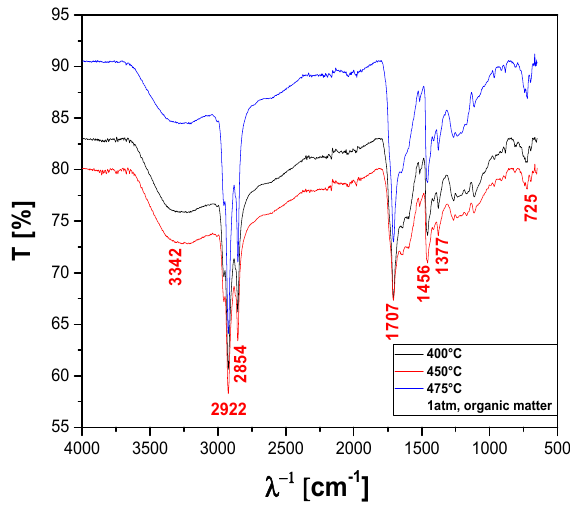
Figure 21. FT-IR of bio-oil obtained by pyrolysis of MHSW fraction (organic matter + paper) at 400, 450, and 475 °C, 1.0 atmosphere, in laboratory scale. The FT-IR qualitative analysis of chemical functions present in the bio-oils obtained by catalytic cracking of MHSW fraction (organic matter + paper) at 475 °C, 1.0 atm, 5.0, 10.0, and 15.0% (wt.) Ca(OH) 2 , in laboratory scale, is shown in Figure 22.